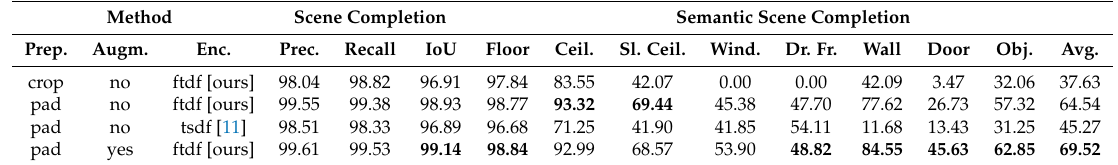
Table 2. Semantic completion results on our testset, with classes floor, ceiling (ceil.), slanted ceiling (sl. ceil.), window (wind.), door frame (dr. fr.), wall, door, object (obj.), and average (avg.). Prep. refers to the preprocessing strategy (padded or cropped), augm. refers to whether or not data augmentation was applied and enc. refers to the input encoding (TSDF [11] or our proposed distance field